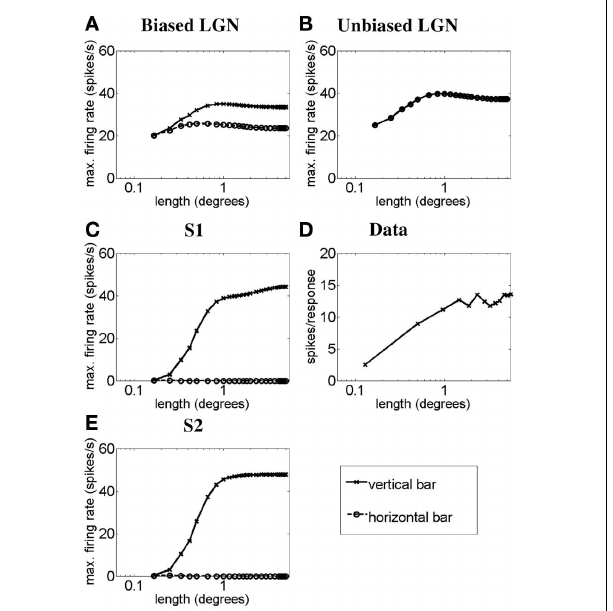
FIGURE 2 | Length–response functions of simple cells S1 and S2 showing length summation. The plots show simulated length–response functions of (A) an ON LGN cell with a vertically biased center and a weak isotropic inhibitory surround, (B) an ON LGN cell with an isotropic center and a strong isotropic inhibitory surround, and (C) the corresponding vertically oriented simple cell S1 in response to a vertical bar (solid lines) and a horizontal bar (dashed lines). (D) The length–response function of a real simple cell with length summation in response to a bar of the preferred orientation (Data adapted from Kato et al., 1978). (E) The response of the vertically oriented simple cell S2 to a vertical bar (solid lines) and a horizontal bar (dashed lines). In (A–C) and (E) the y -axis represents the maximum firing rate (spikes/seconds) reached before the bar is switched off, and the x -axis represents the bar length in degrees. In (D) the y -axis represents number of spikes recorded per response to a bar (as defined by Kato et al.,